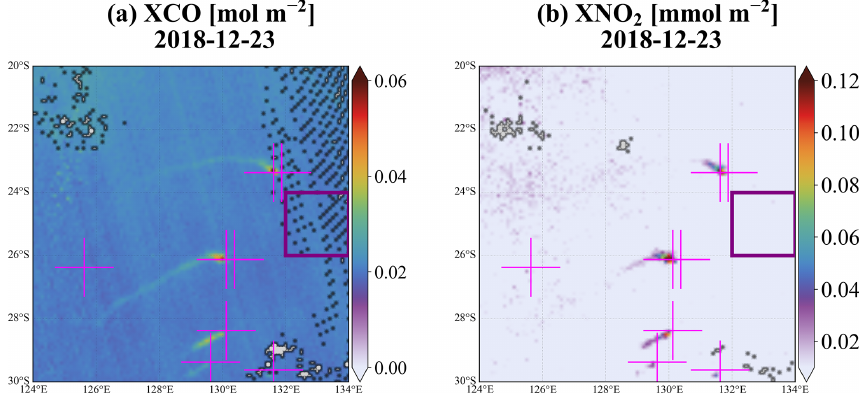
Figure 5. The column density X CO (molm − 2 ) in panel (a) and X NO 2 (mmolm − 2 ) in panel (b) measured with TROPOMI on 23 Decem- ber 2018 over central Australia. The background region is depicted by the purple frame and is located upwind of multiple fire plumes. The locations of the GFED4s/GFAS fire emissions are depicted by the magenta plus signs.